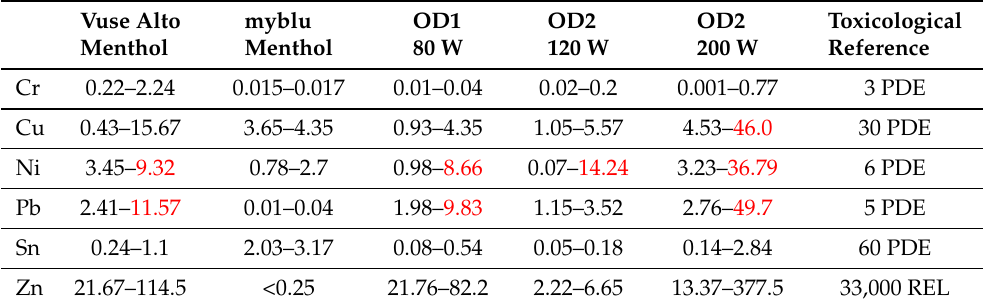
Table 9. Daily exposure (in µ g) of the Vuse Alto and myblu Menthol favors examined by Gray et al. [15]. A comparison (higher levels in red) is offered with daily exposure from same metals tested by Zhao et al. [11] on high power sub-ohm devices. The daily exposure was computed assuming 250 daily puffs. Vuse Alto